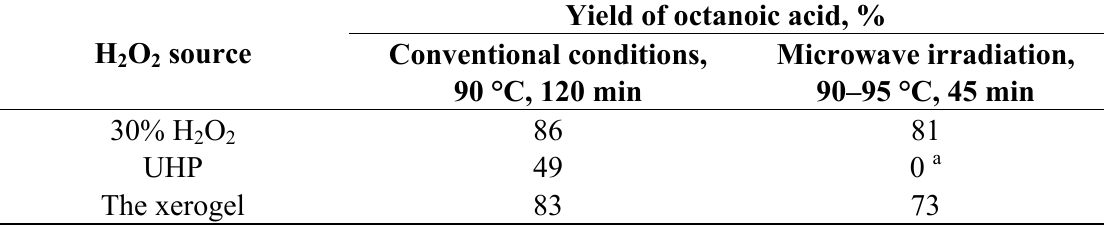
Table 1. Effect of a source of H microwaves conditions.